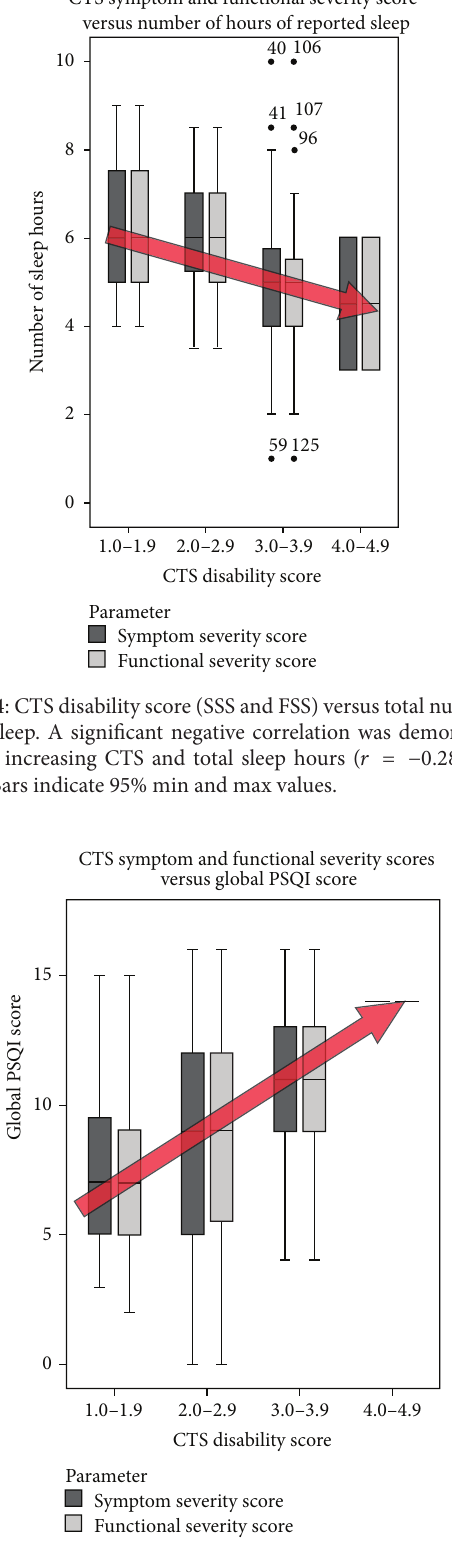
Figure 5: CTS disability score (SSS and FSS) versus global PSQI. A significant correlation was demonstrated between increasing CTS and increasing global PSQI score ( 𝑟 = 0.506 , 𝑃 < 0.000 ). Bars indicate 95% min and max values.